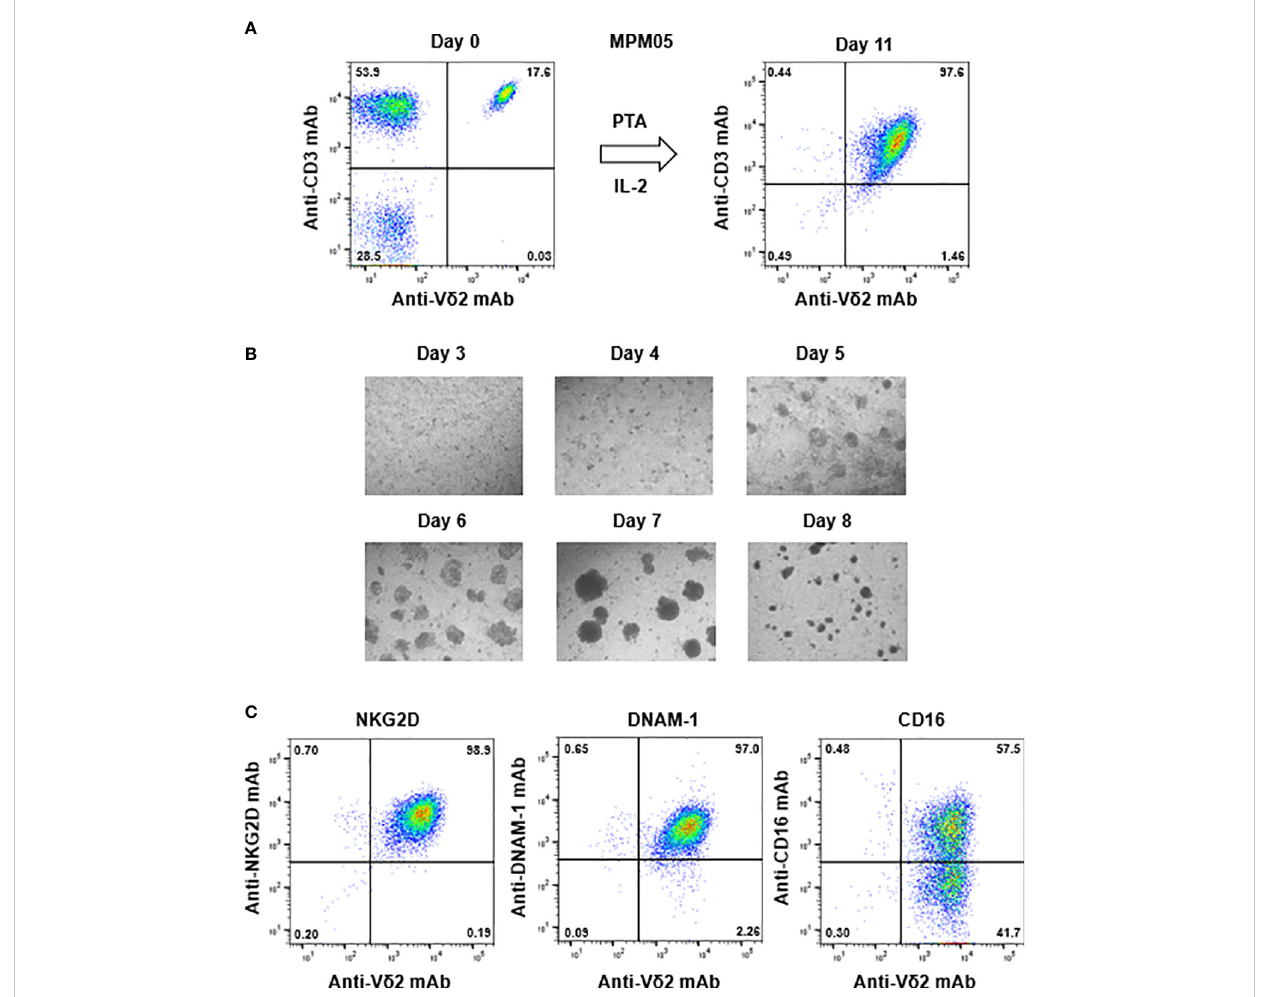
FIGURE 4 Expansion of gd T cells from PBMC derived from an MPM patient. (A) PTA-driven expansion of gd T cells. PBMC derived from MPM05, an MPM patient, was stimulated with PTA and expanded in the presence of IL-2 for 11 days. The purity of gd T cells were monitored through fl ow cytometry. (B) Microscopic analysis of the time course of gd T cells proliferation. MPM05-derived PBMC stimulated with PTA/IL-2 were monitored under a microscope on days 3, 4, 5, 6, 7 and 8. (C) Flow cytometric analysis of gd T cells derived from MPM05. After expansion with PTA/IL-2 for 11 days, MPM05-derived gd T cells were examined for the expression of NKG2D, DNAM-1 and